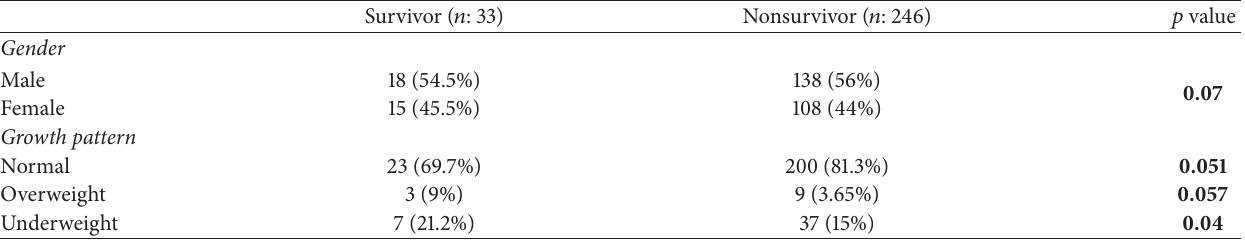
Table 5: Gender and growth status.